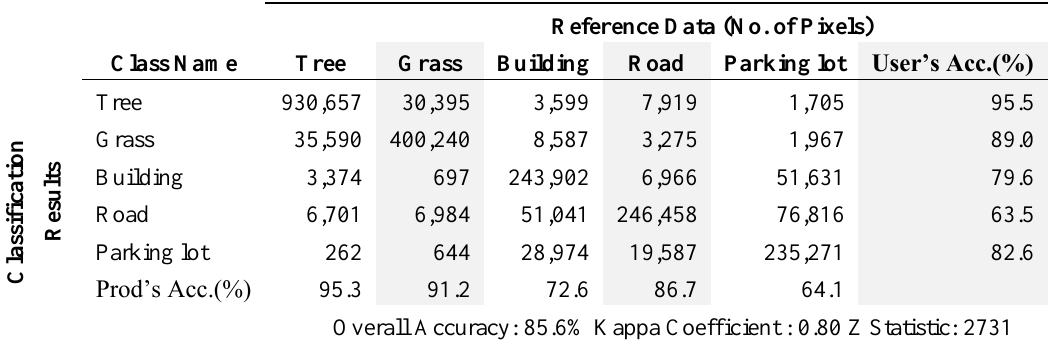
Table 5. Classification results for the IK Test